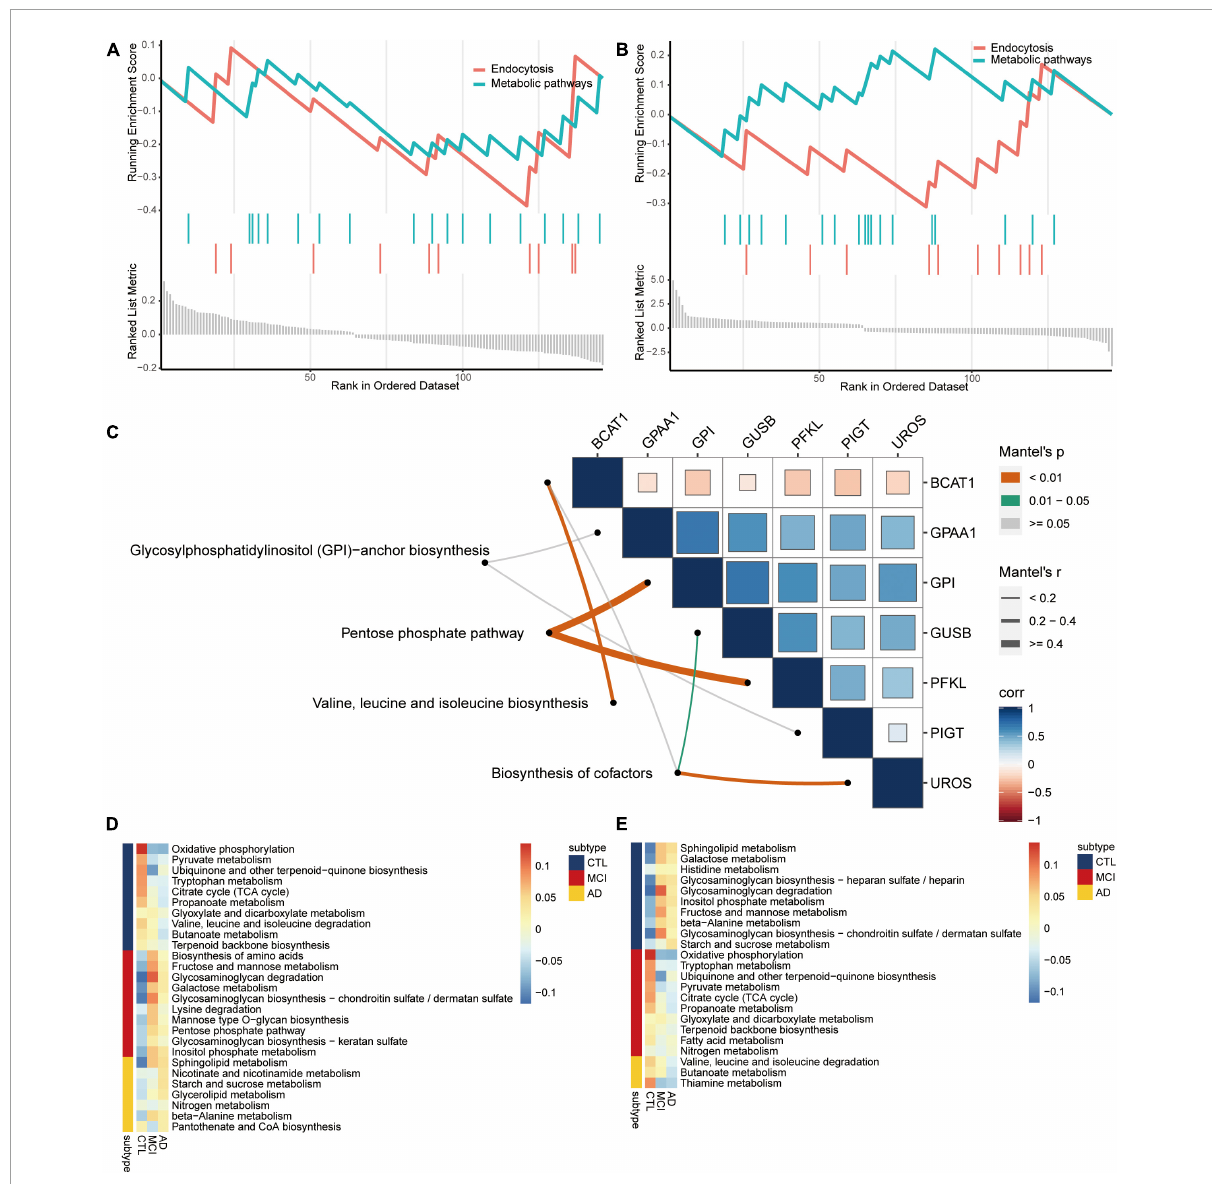
FIGURE4 Metabolism pathways are involved in the disease course of AD. Same KEGG pathways of GSEA in AD (A) and CSVD (B) . (C) Correlations among metabolism pathways and common DEGs. Corr, correlation. Metabolism pathways were quantified for upregulated (D) or downregulated (E) from AD to MCI, then to controls. AD, Alzheimer’s disease; CTL, controls; MCI, mild cognitive